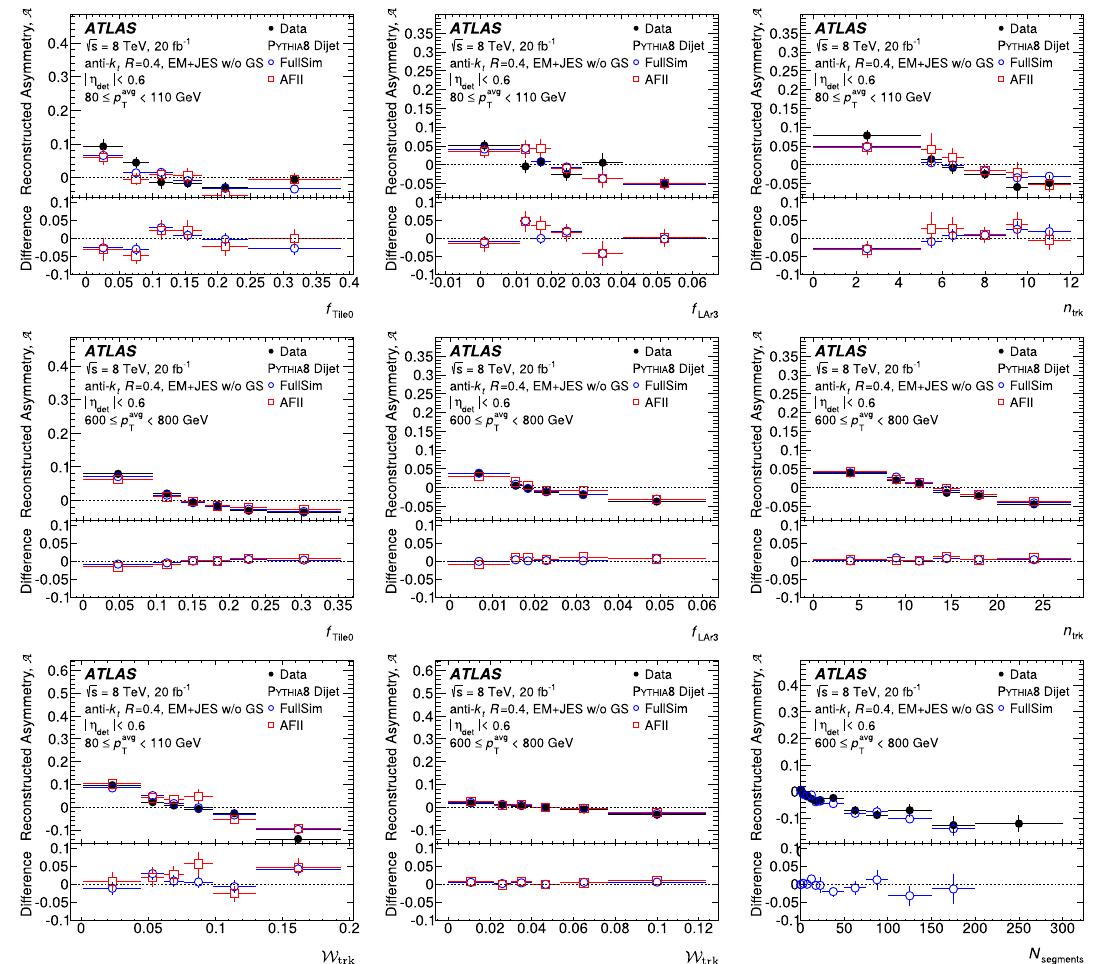
Fig. 13 Dijet in situ validation of jet response as a function of f Tile0 , f LAr3 and n trk for jets with 80GeV < p avg (top) and for jets with 600GeV < p avg (middle) and the same quantity as a function of W trk and N segments